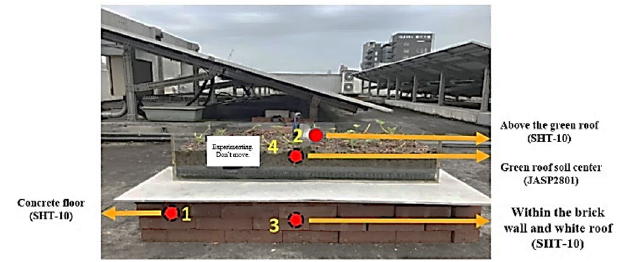
Figure 5. Placement of sensors on the green roof.